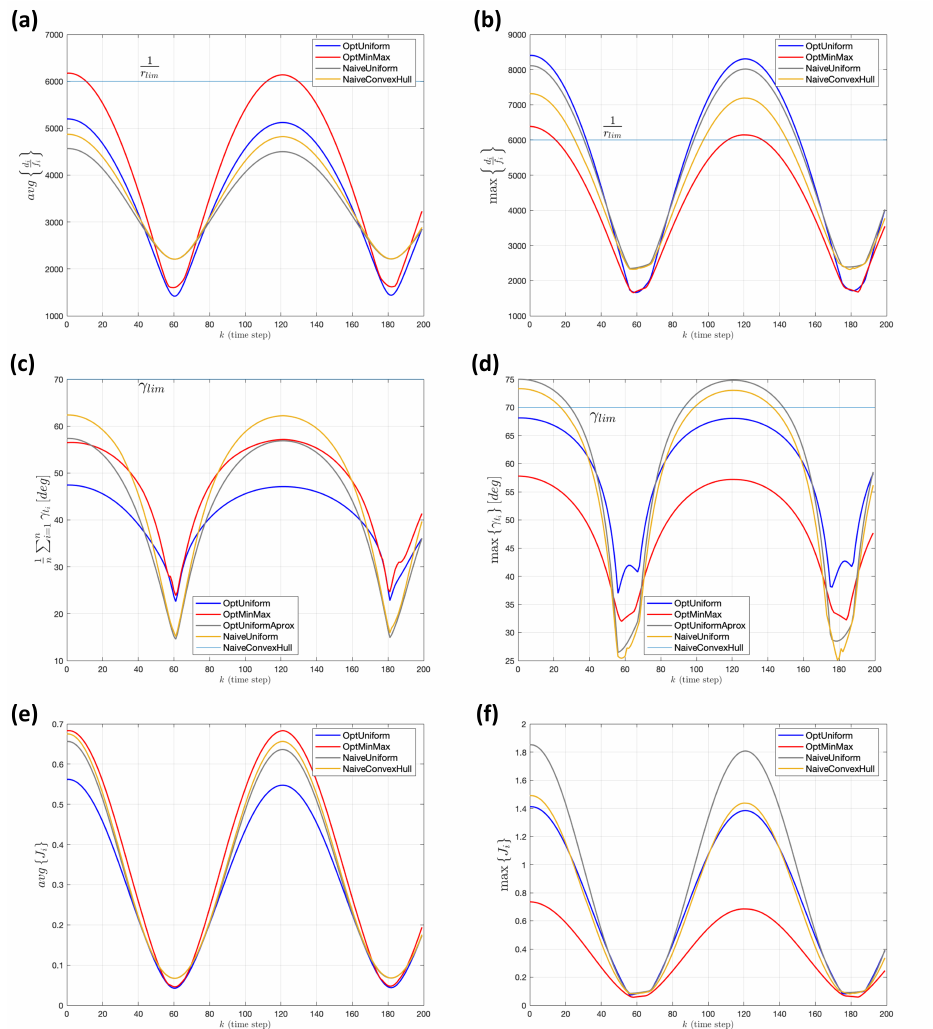
Figure 15. Experiment 2. ( a , b ) Instantaneous mean and maximum values in optical range , respectively. ( c , d ) Corresponding mean a maximum measures for the deficit in verticality . ( e , f ) Mean and maximum values of the set of individual optimization terms J i